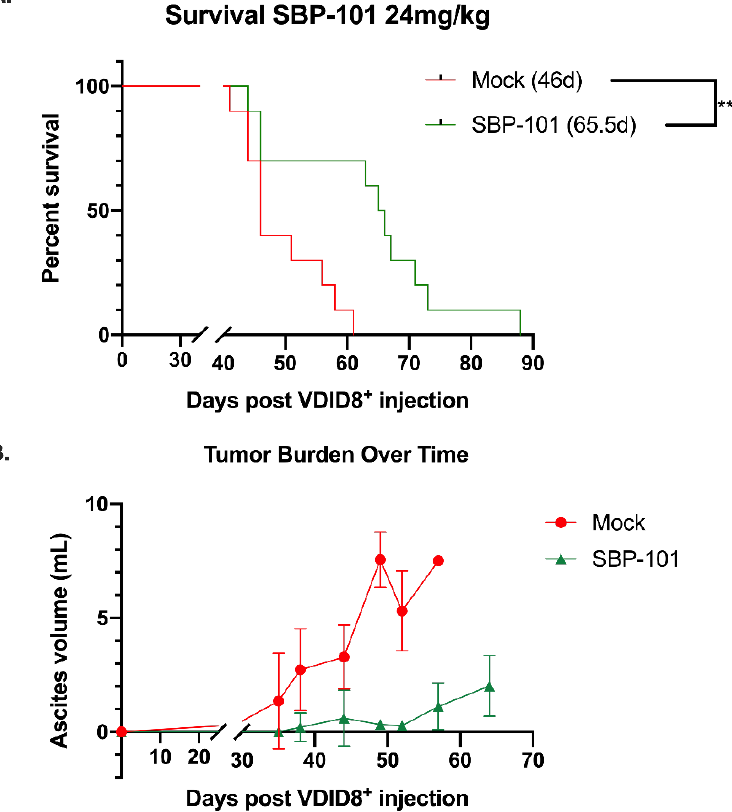
Figure 5. SBP-101-treated VDID8 + mice ( n = 10) show a delay in tumor progression and a decrease in overall tumor burden that is correlated with an increase in median survival. Female C57Bl/6 mice were injected with 250,000 VDID8 + mouse ovarian surface epithelial cells and subsequently treated with 24 mg/kg SBP-101 (3× per week, alternating weeks, three cycles). The median survival for